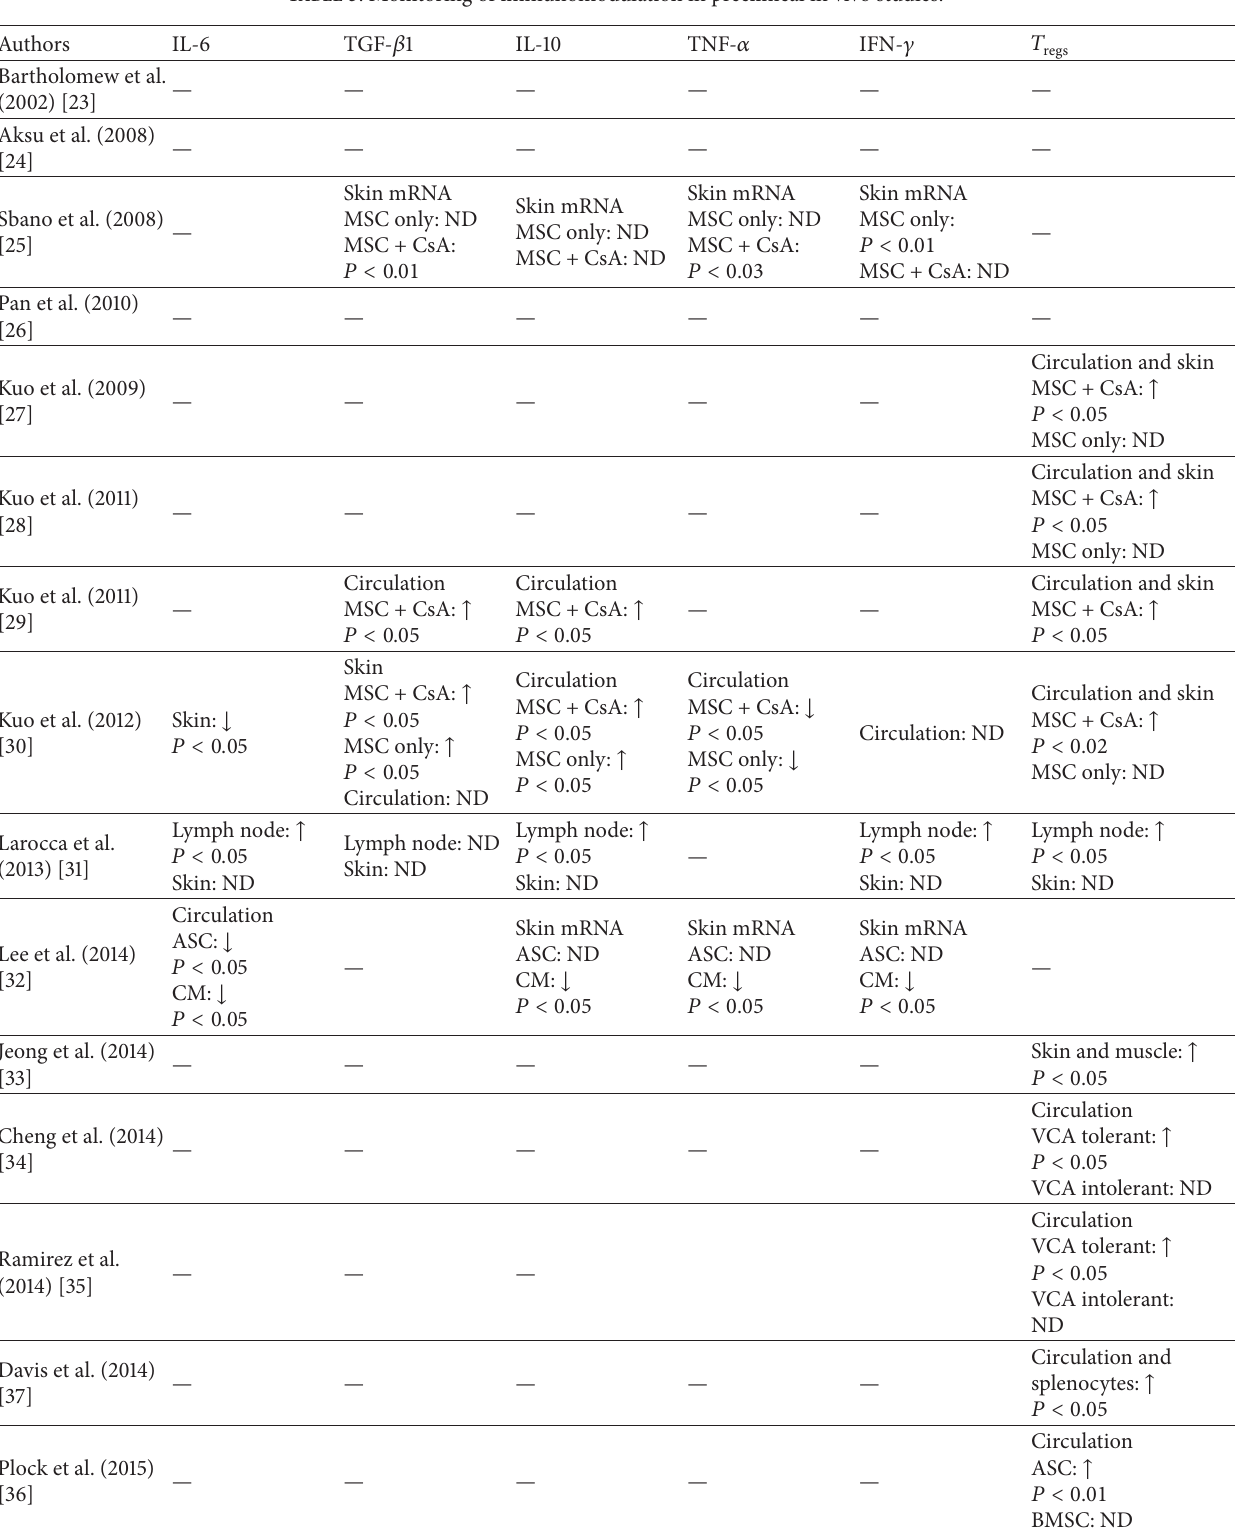
Table 3: Monitoring of immunomodulation in preclinical in vivo